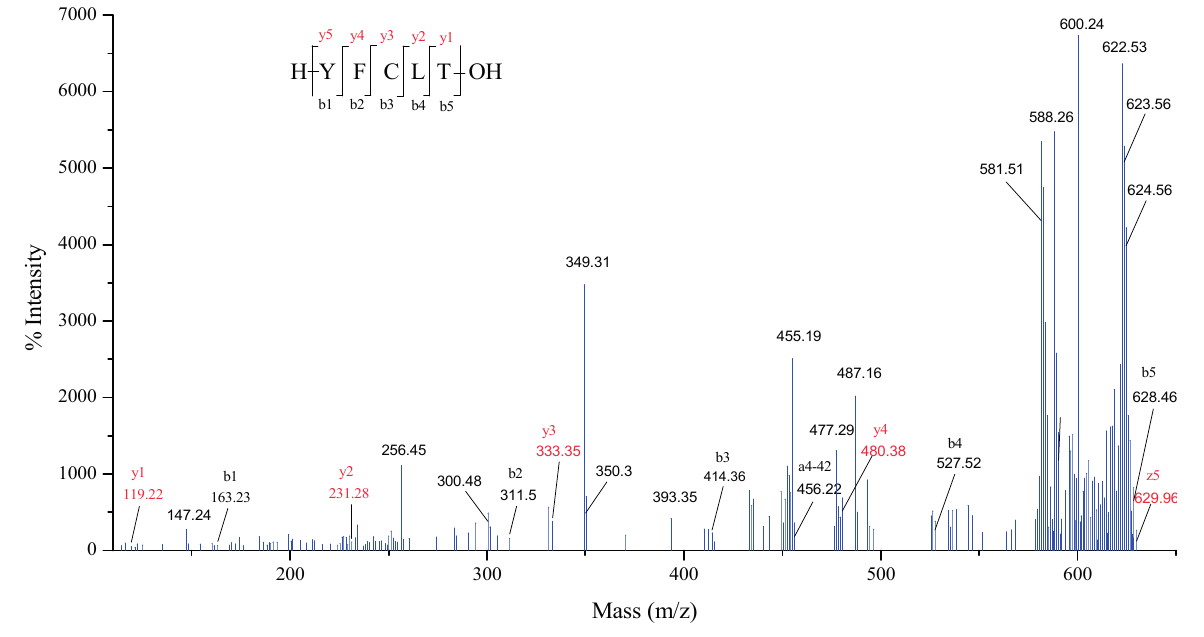
Figure 4. Identi fi cation of antioxidant peptide: MS/MS spectra of singly charged ion with m/z 644.07 was determined to be the peptide sequence of YFCLT.